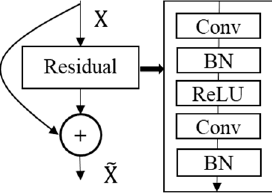
Figure 5. Residual connection. Each residual block is composed by convolutions (Conv), batch normalizations (BN) and rectified linear units (ReLU).